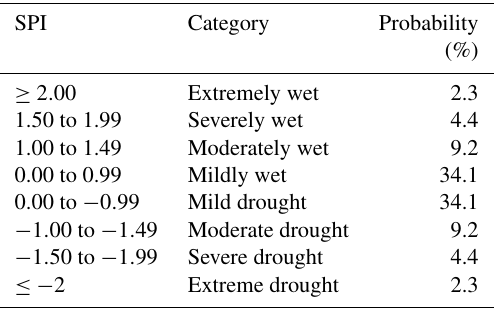
Table 2. Parameters for the water balance model used in this